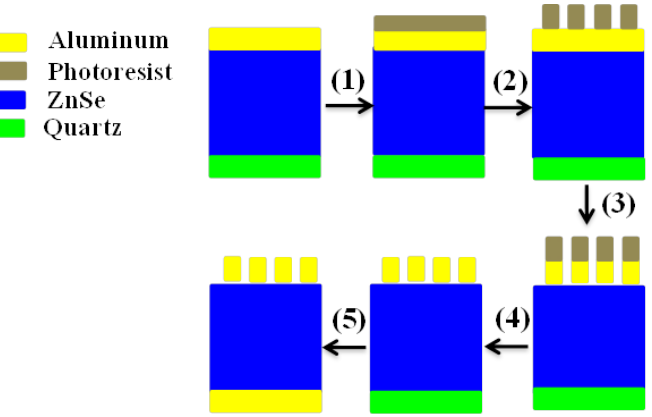
Figure 12. Process flow: (1) and (2) is the photolithography to define the metamaterial geometry, while (3) and (4) show the wet etching and washing of the photoresist to fabricate the metamaterial structures, and (5) is the evaporation of metallic substrate layer on another side of the ZnSe layer. Table 2. Comparison of the sensing performance between the proposed works with similar THz absorber-based sensor